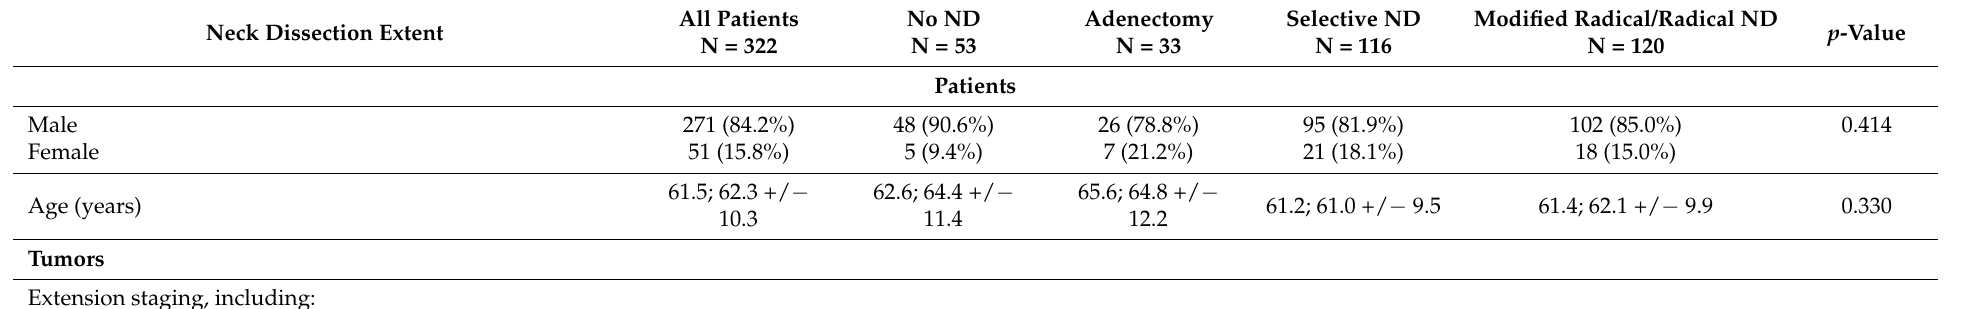
Table 1. Patient and tumor